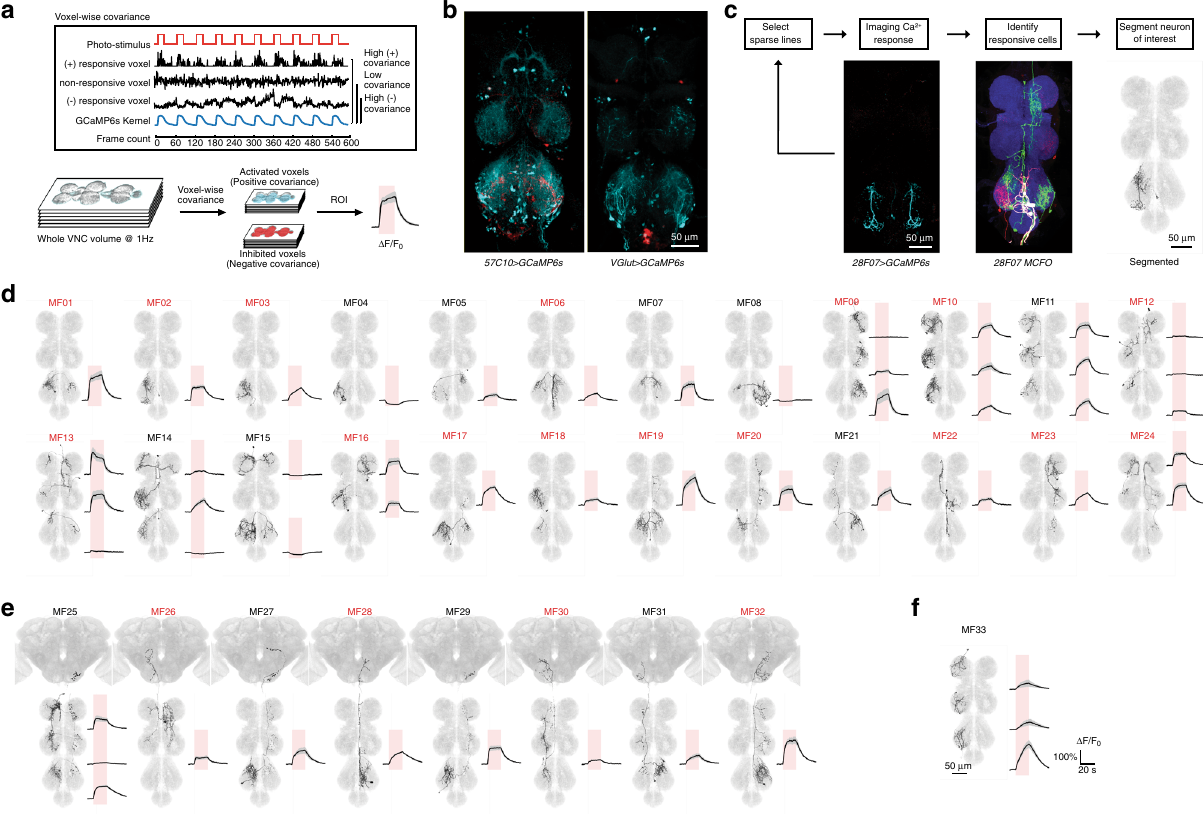
Fig. 3 MDN-responsive neurons identi fi ed by functional imaging. a Schematic of the functional imaging and data analysis pipeline. b Maximum intensity projections of imaged VNC volumes during photostimulation, using MDN-1-GAL4 to drive Chrimson88 in MDNs. Cyan represents activated voxels; red represents inhibited voxels. See also Supplementary Movie 3. We recorded from at least 5 independent samples for each genotype and obtained similar results across the samples. c Top, pipeline for discovering cell types that are functionally connected to MDN. Bottom, an example showing how an MDN- responsive cell type is identi fi ed. The three images are, from left to right, a maximum intensity projection of activated voxels in the VNC of a fl y in which Chrimson88 expression is driven by MDN-1-GAL4 and GCaMP6s expression is driven by 28F07-LexA , a multi-color fl ip-out (MFCO) image from the corresponding 28F07-GAL4 driver, and a single cell segmented from the MCFO image that matches the morphology of the MDN-responsive neurons. d Twenty-four MF interneuron types, whereby segmentally repeated cells are classi fi ed as the same cell type. Maximum intensity projections of segmented and registered images are shown on the left; averaged responses to MDN activation on the right (mean ± s.e.m. of n ≥ 5 samples; red shading indicates the 20 s red-light stimulus; see also Supplementary Fig. 2). Cell types labeled in red were also identi fi ed in the trans-Tango experiments (see Supplementary Fig. 1 for pairwise comparisons). e Eight MF ascending neuron types and their calcium responses to MDN activation. f The single MF motor neuron type and its calcium response to MDN activation. Each cell type in d-f is given a provisional name beginning with “ MF ” ( “ MDN functional imaging ”